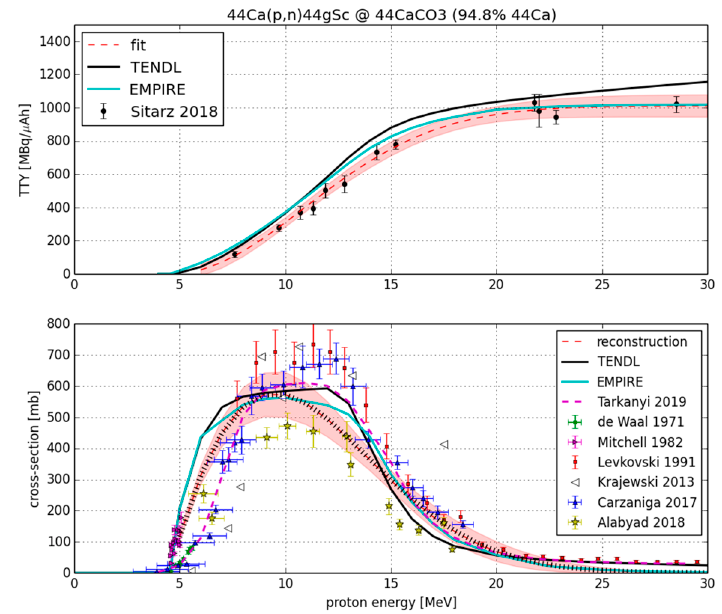
Figure 2. Reconstruction of 44 Ca(p,n) 44g Sc cross-section (bottom) based on the fit to TTY data on 44 CaCO 3 enriched in 94.8% 44 Ca (top). The cross-section data points are taken from [26,29,31–34,36].